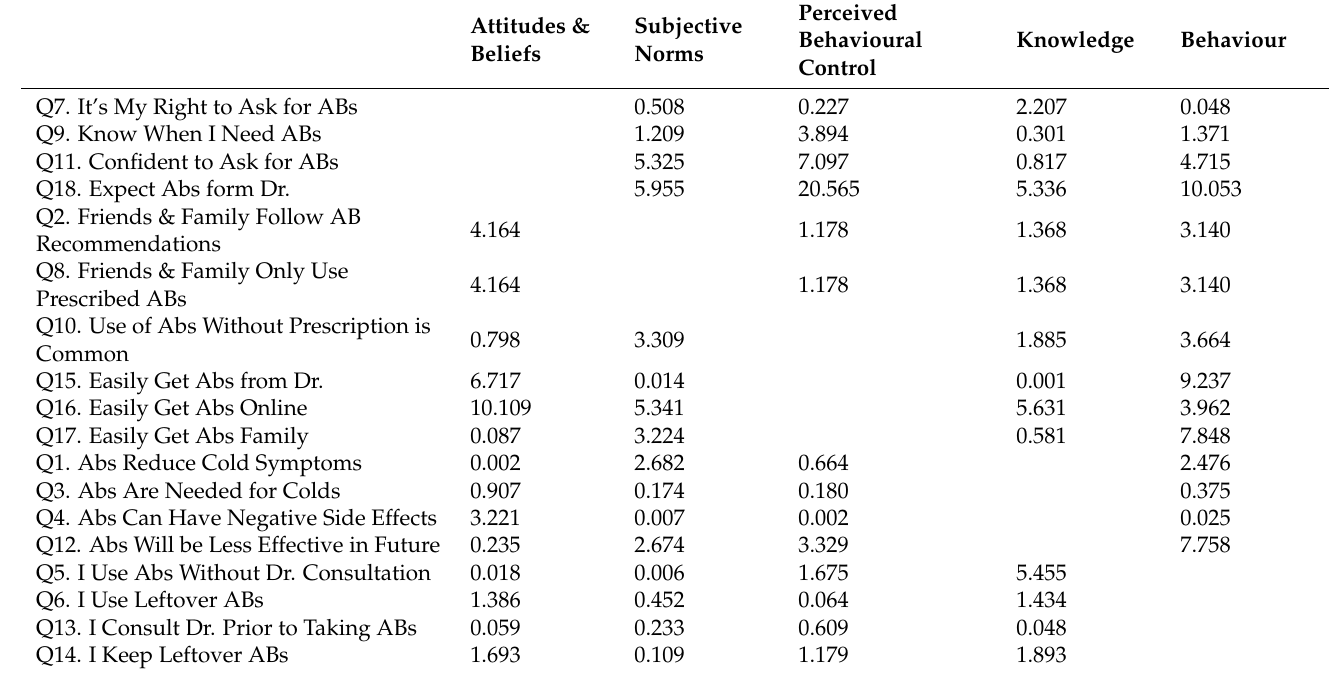
Table 4. CFA Modification Indices for In-Person Group Factor Loadings.